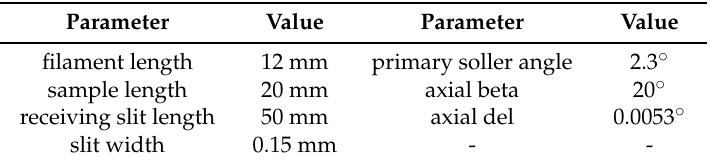
Table 1. XRD instrument parameters.